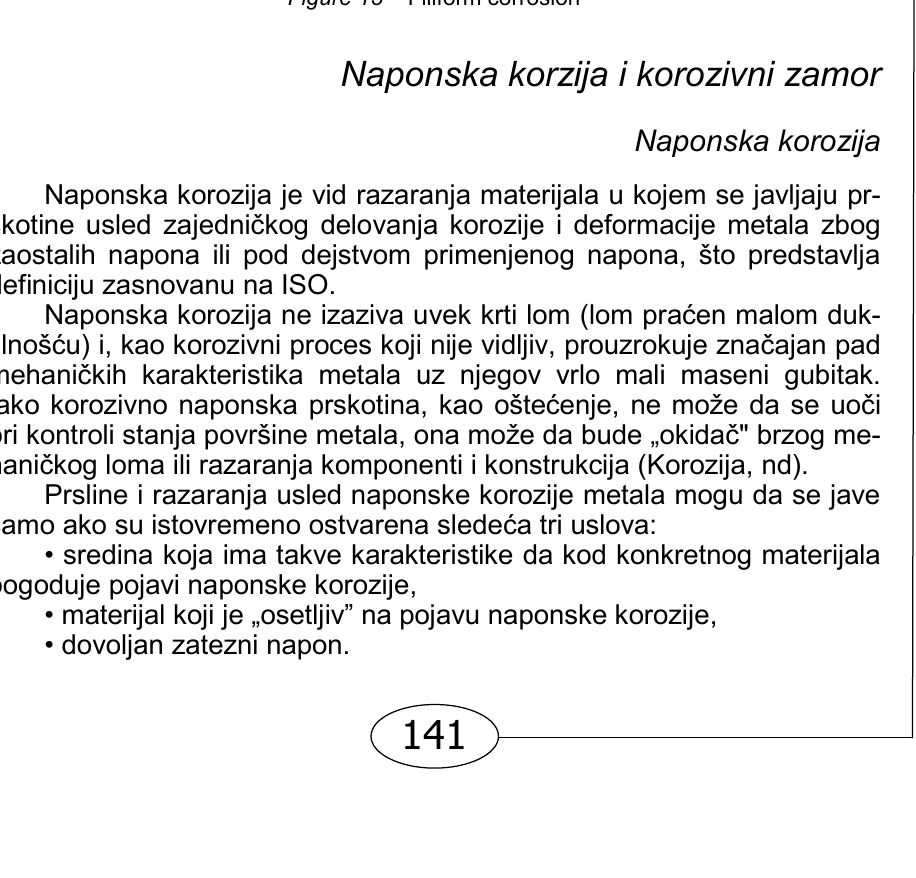
Figure 15 – Filiform